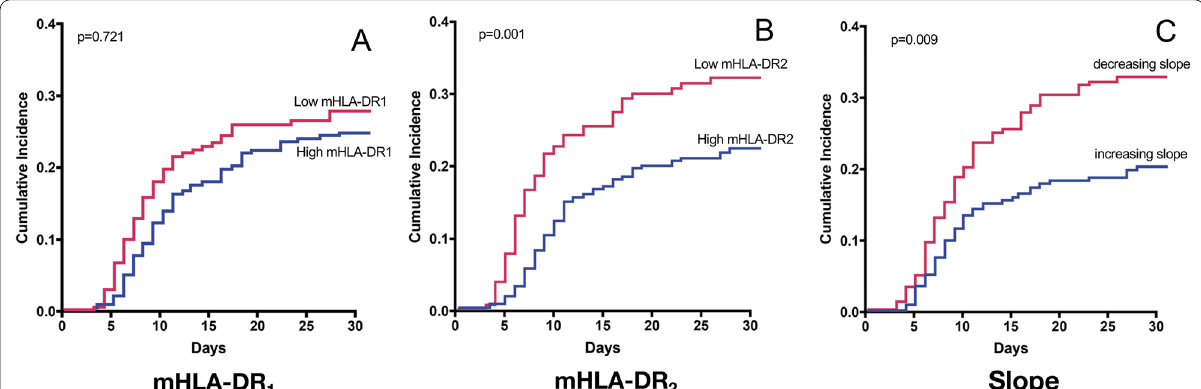
Fig. 2 Cumulative incidence of the occurrence of nosocomial infection depending on different levels of early mHLA-DR expression ( A ), second mHLA-DR expression ( B ), and depending on the trend of mHLA-DR ( C ) in patients with two measurements ( n